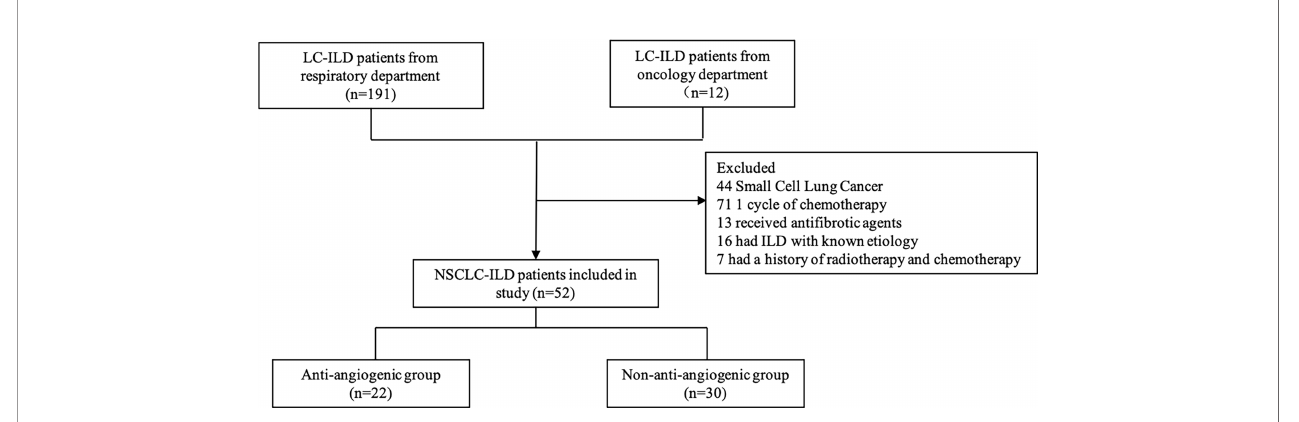
FIGURE 1 | Flow Chart Diagram of Patients Selection.